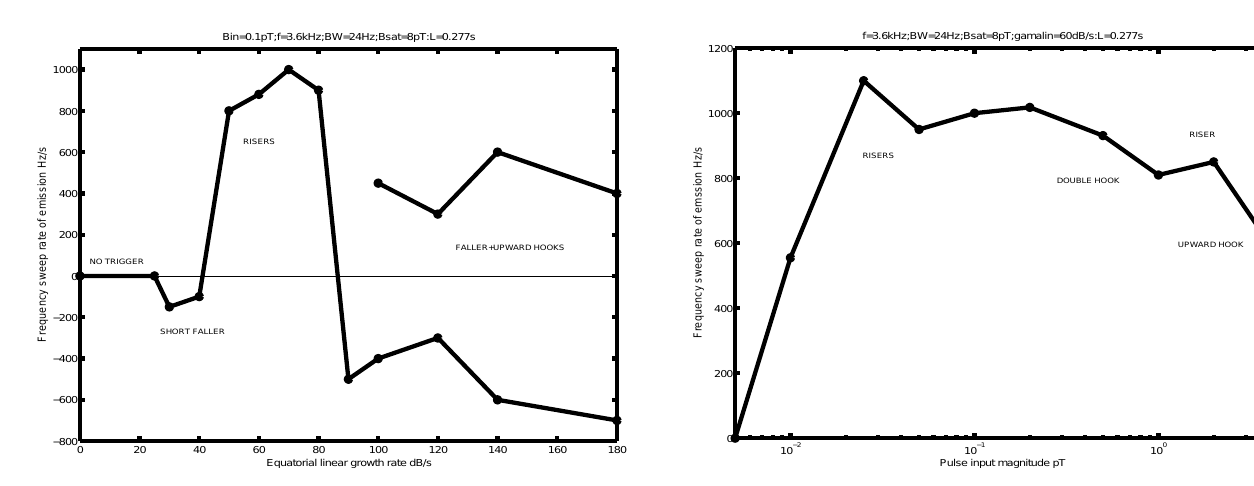
Fig. 8. Dependence of the emission sweep rate on the linear growth rate at the geomagnetic equator at L=4.4. Note the weak fallers at low growth rates, risers at intermediate growth rates and fallers, or hooks, at high growth rates.